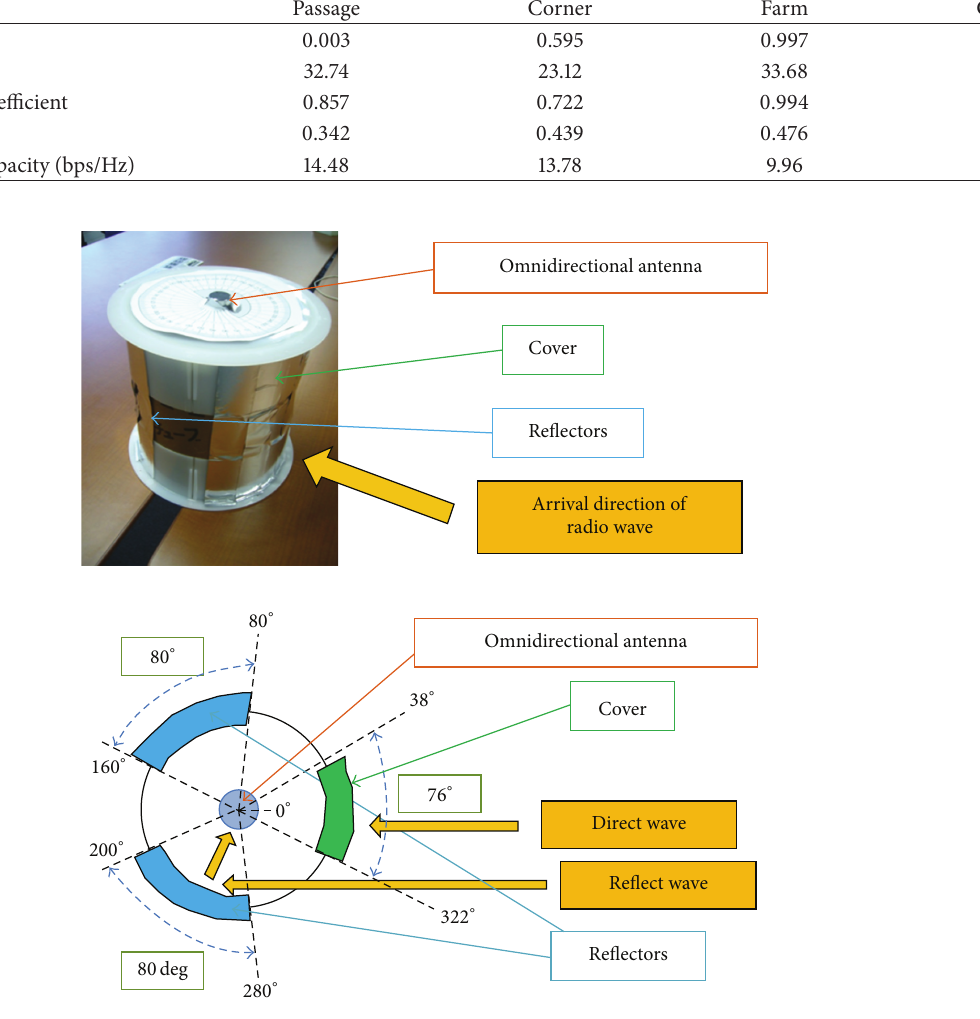
Figure 13: Proposed cover and